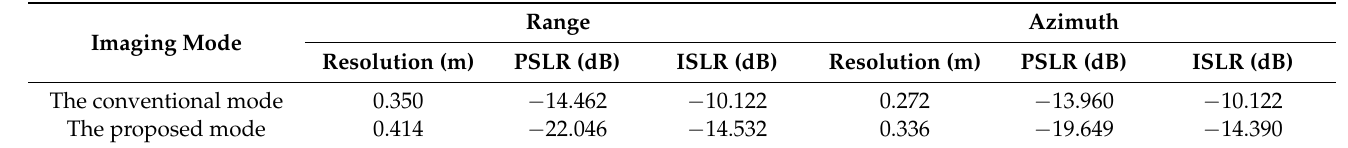
Table 3. Measured focusing parameters of the point target P in Figure 11.